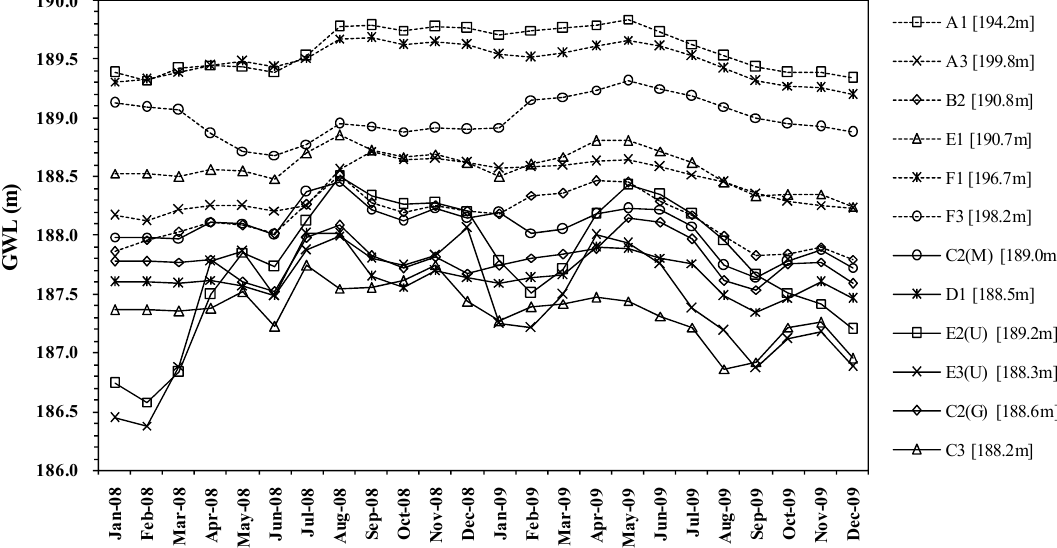
Fig. 4. Monthly ground water level (GWL) at the measurement sites (Table 2). Site A1, A3, F1 and F3 are located in the sandy dunes (high altitude, 186.2 to 200.3m); site B2, E1, E2(U) and E3(U) are located in the transitional zones (medium altitude, 185.8 to 190.7m); and site C2(G), C2(M), C3 and D1 are located in the meadows lands (low altitude, 188.6 to 189.5m). The ground surface level is given in the parentheses next to the site name.